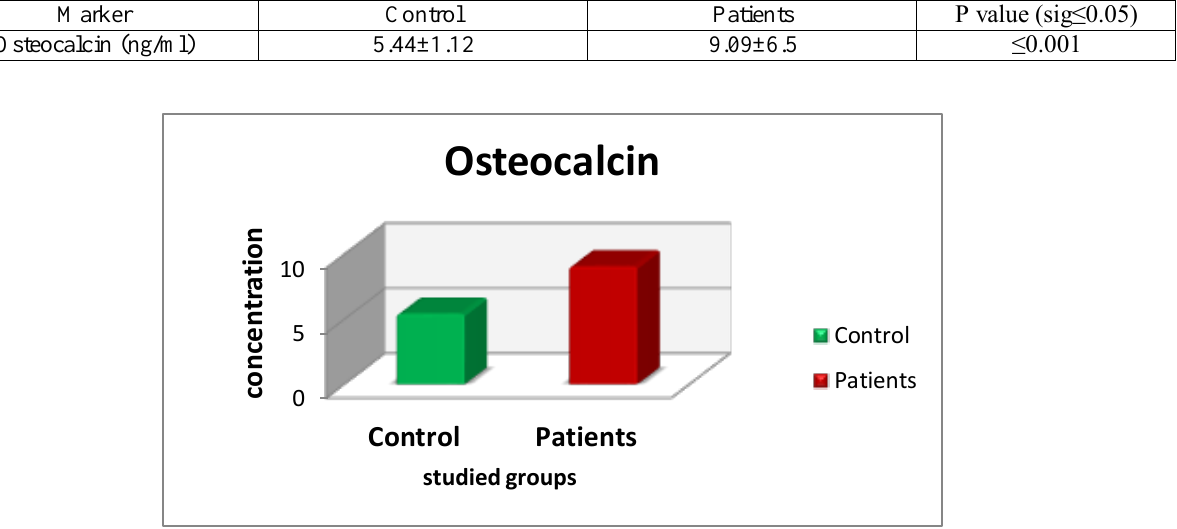
Figure 7: Levels of osteocalcin in patients and control groups.